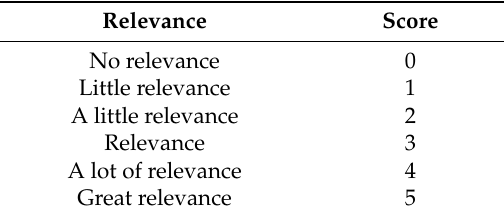
Table 2. Saliency scoring criteria. Relevance indicates the informativity of the summary by the model (our model or See et al. [16] model). Score is from 0 to 5 and higher scores are better. Higher score indicates higher